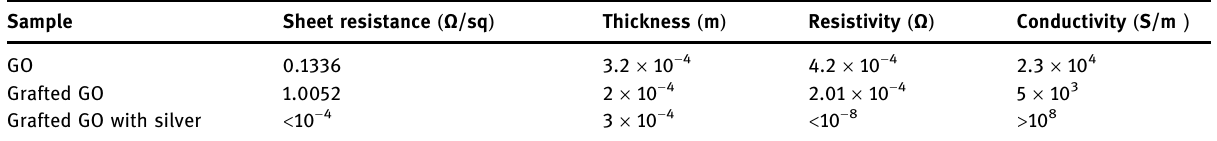
Table 1: Conductivity of GO before and after the surface modi fi cation